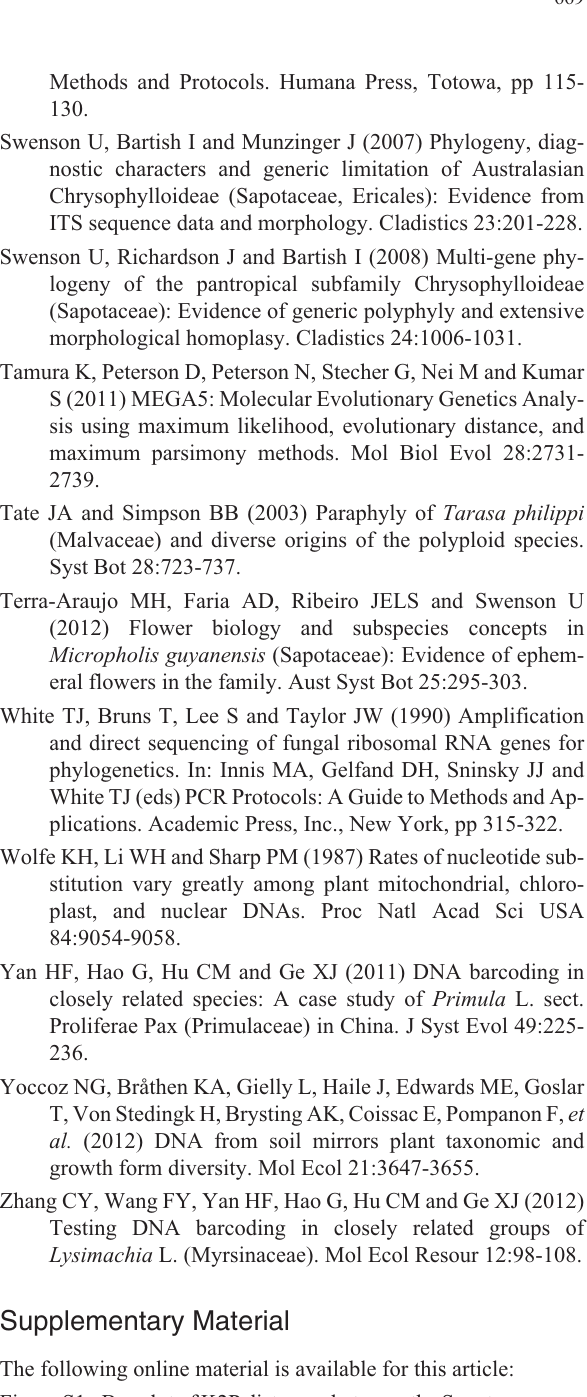
cies considered in this study using ITS, matK , rbcL and trnH-psbA markers. Table S1 - Voucher information and GenBank accession numbers